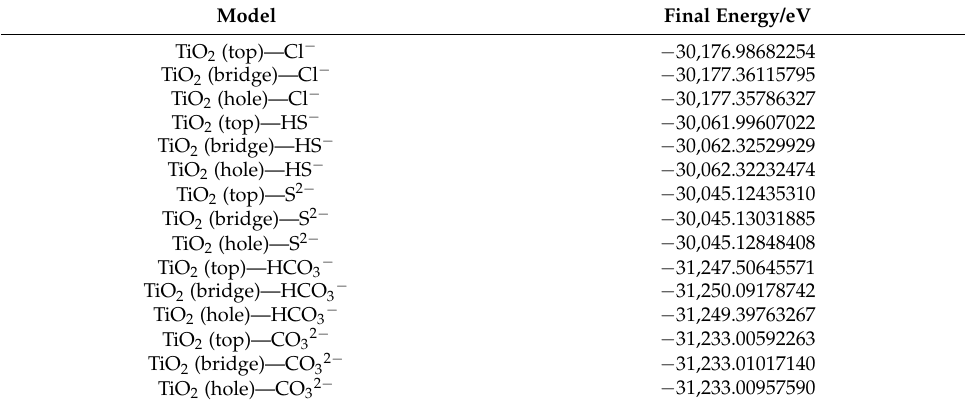
Table 2. The final energy of each corrosive species at each adsorption position on the TiO 2 (110) crystal face after geometric optimization.